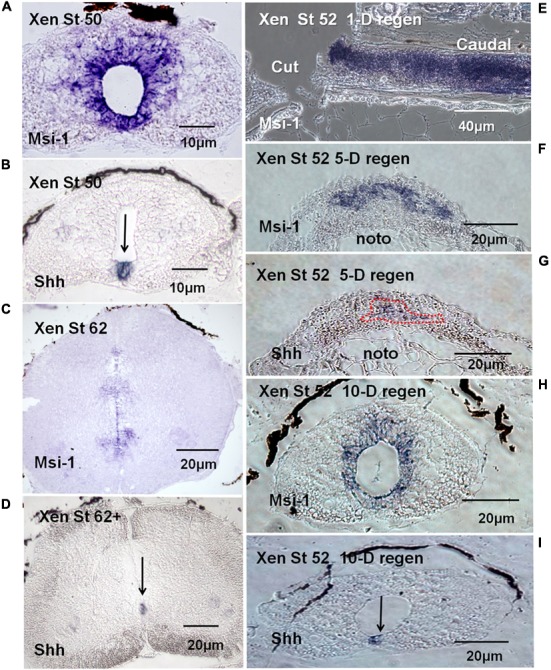
mRNA tissue distribution of Xenopus Msi-1 in developing and regenerating spinal cord using section in situ hybridization (blue reaction product). (A) Cross section of intact NF 50 spinal cord. Msi-1 was strongly expressed in the ependymal layer. (B) Shh mRNA localization in intact NF 50 spinal cord in the section adjacent to the one shown in “A.” Shh is expressed in the floorplate (arrow). (C) NF 62 spinal cord cross section showed Msi-1 was still expressed in the ependymal layer, but mostly ventrally located and weaker. (D) NF 62+ Shh mRNA is still expressed in the ventral floorplate, overlapping the Msi-1 expression (arrow). (E) Parasagittal section of NF 52 spinal cord 1-day (1-D) post-transection showed high level of Msi-1 expression throughout the cord, lesion site and caudal stump. (F) Cross section of NF 52 regenerating cord 5-days (5-D) post-transection showed a broad ventral arch of Msi-1 expression in the ependymal outgrowth. The dorsal portion of the notochord is visible below the outgrowth (noto). (G) Cross section of NF 52 regenerating cord 5-days (5-D) post-transection in the section adjacent to the one shown in “F”. Shh localization is largely in a complementary zone of outgrowth ventral to Msi-1 expression. (Combined Msi-1 and Shh expression shown in Supplementary Figure 6.) The dorsal portion of the notochord is visible below the outgrowth (noto). (H) Cross section of lesion site in NF 52 spinal cord 10-days (10-D) post-transection showed the reconstructed central canal with ependymal Msi-1 expression. (I) NF 52 spinal cord 10-days post-transection (10-D) in the section adjacent to the one in “H” showed Shh expression restored to floorplate location. Differential interference contrast optics, transmitted light images.